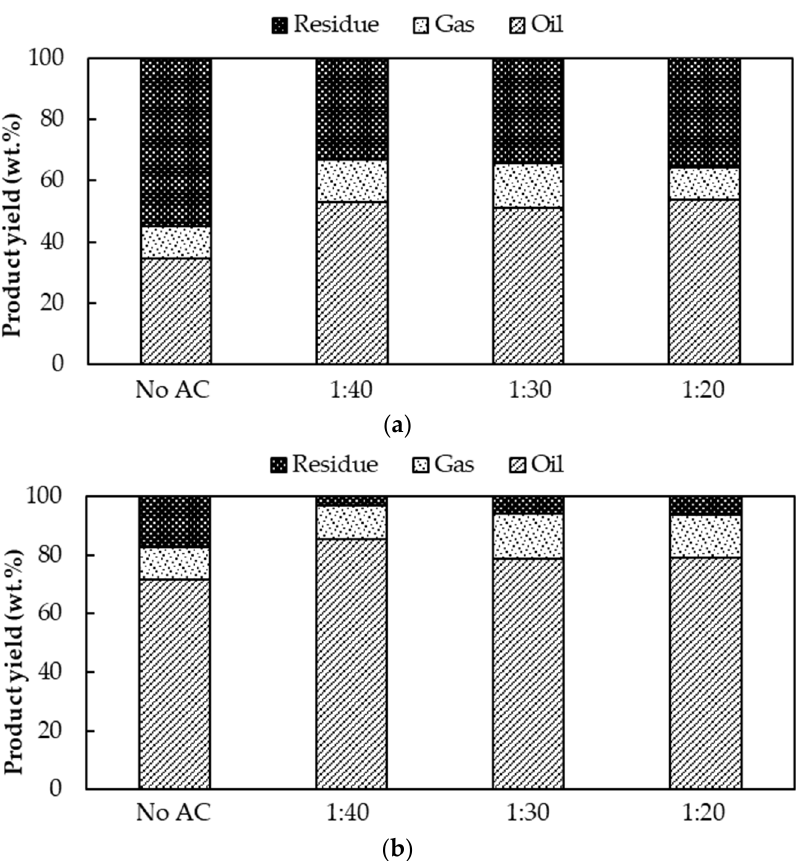
Figure 7. The product yield distribution obtained from pyrolysis at various AC:WCO mass ratios at the process temperature ( a ) at 350 °C; ( b ) 400 °C.